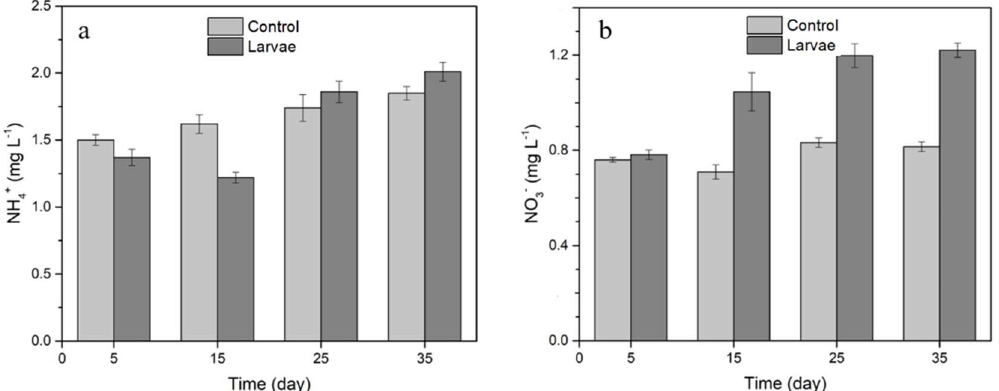
Figure 3. Ammonium nitrogen (NH 4+ ) and nitrate nitrogen (NO 3− ) profiles in the overlying water of the control and the Chironomid larvae treatment. ( a ) NH 4+ and ( b ) NO 3− .